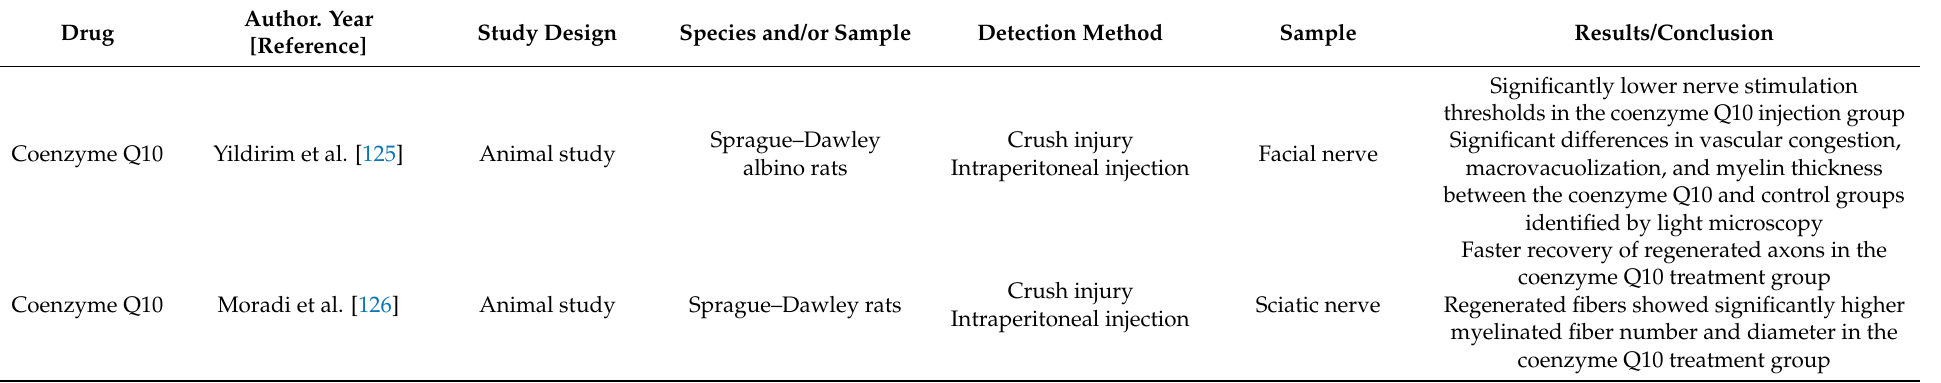
Table 9. Summary of studies assessing the use of coenzyme Q10 biloba for the treatment of peripheral nerve